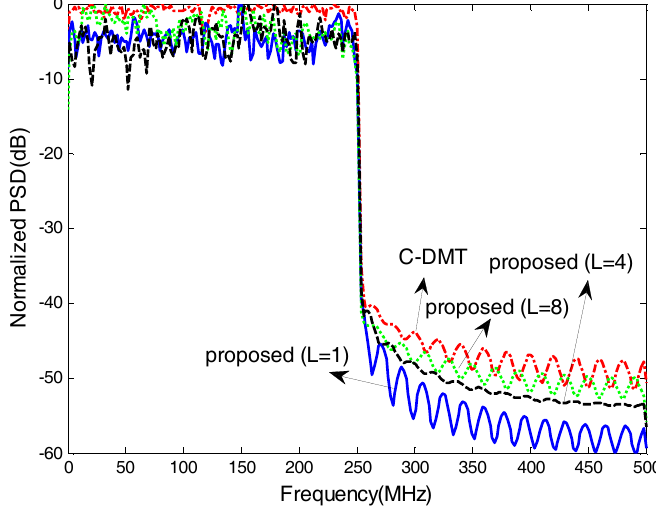
Figure 8. Power spectral density (PSD) performance comparison.